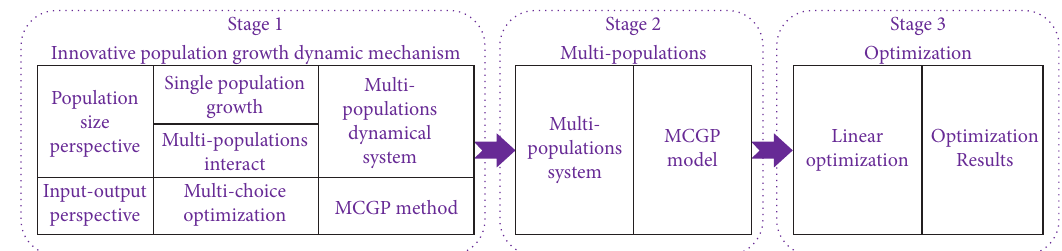
Figure 1: Innovation population-scale evaluation